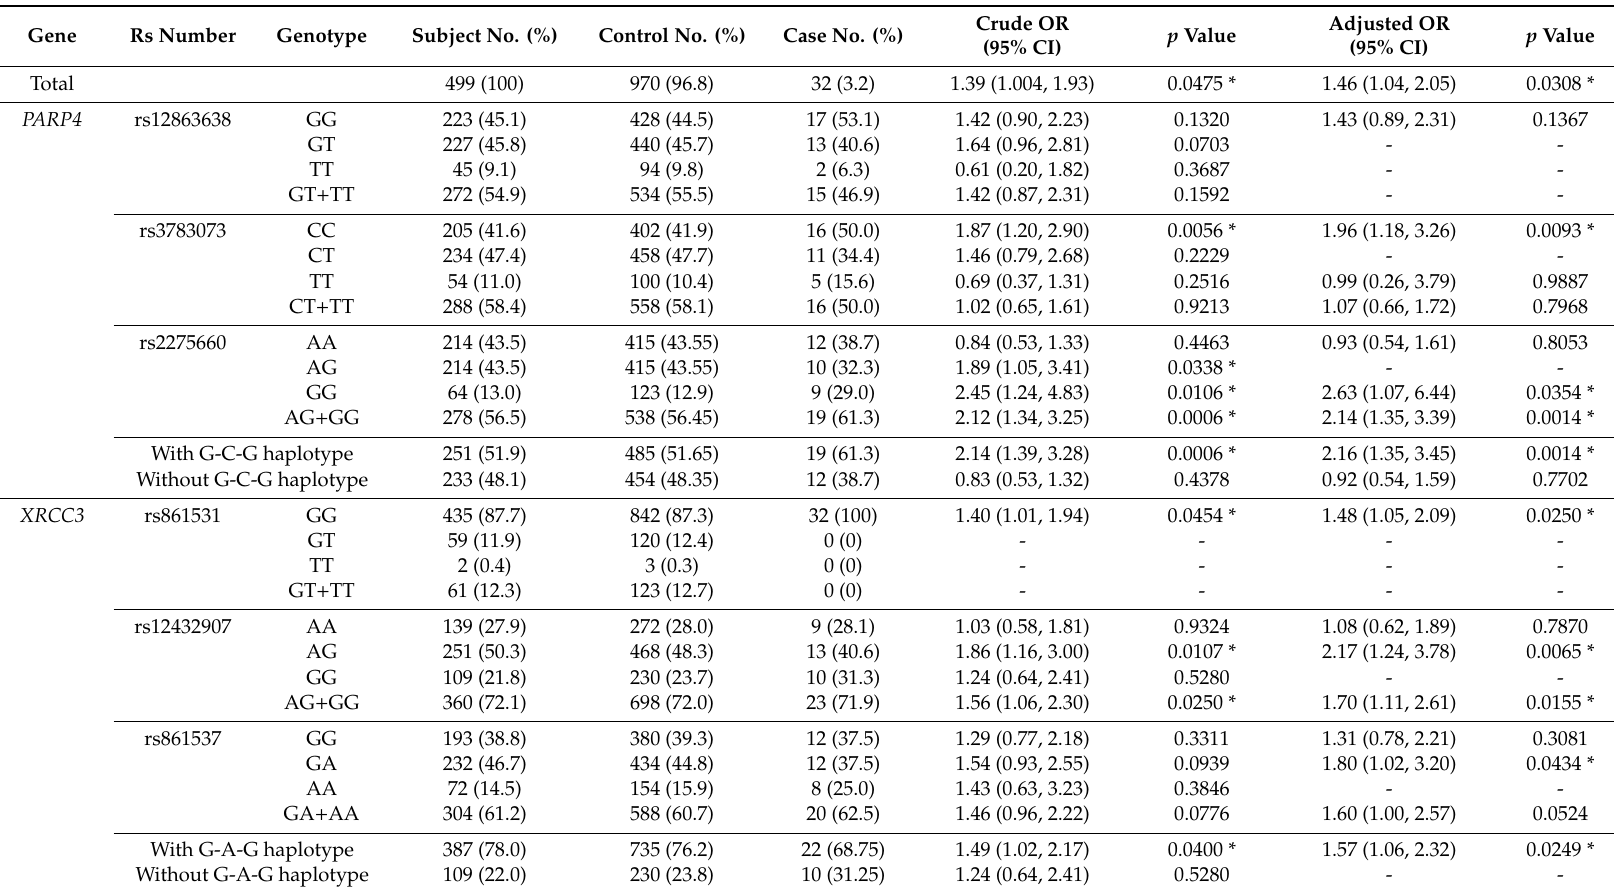
Table 5. The relationships between BPA exposure and liver abnormality by repair gene polymorphisms and combined